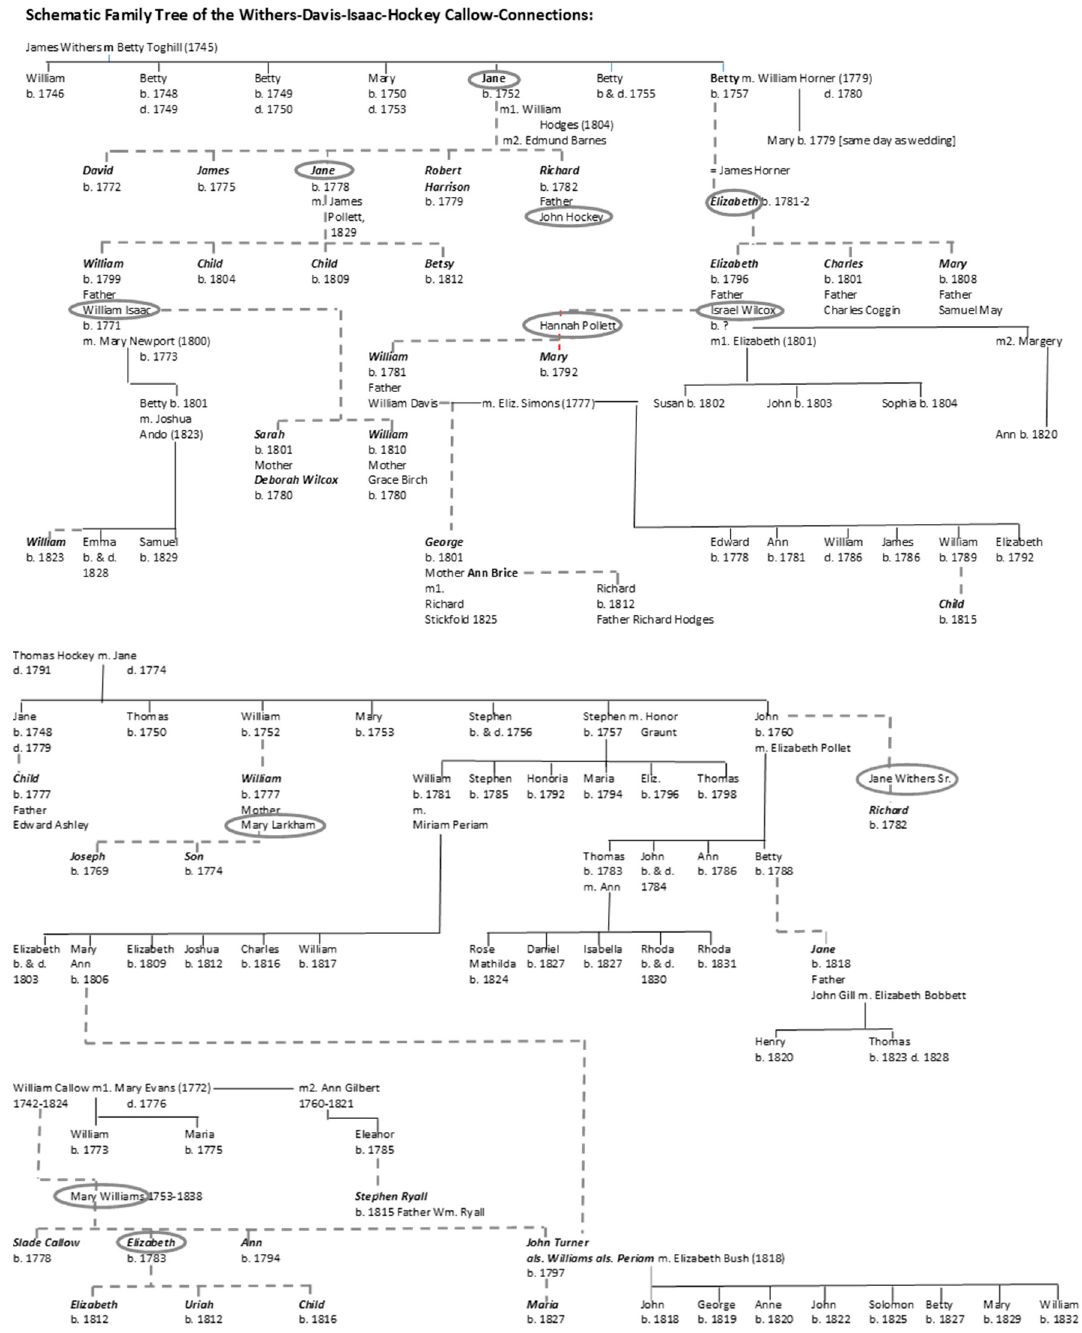
Figure 5. Age at Which Women Registered First Child, All Women vs. Mothers of Illegitimate Children, Butleigh, Somerset,